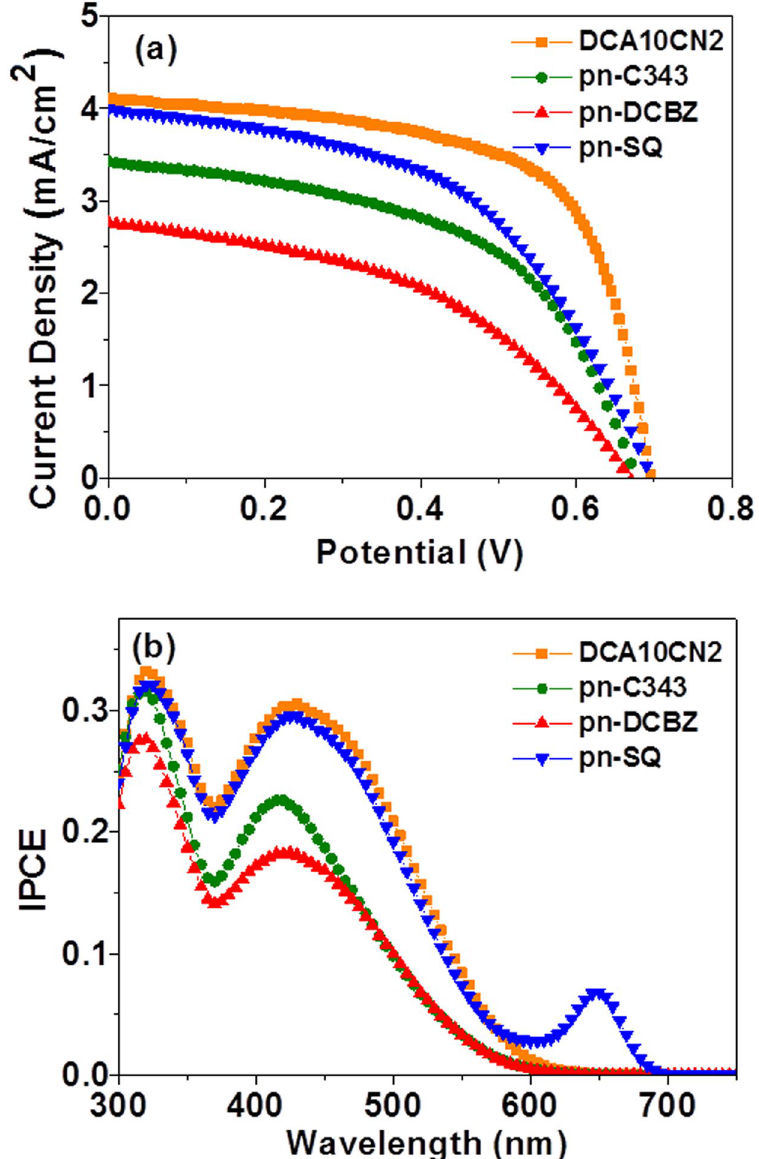
Figure 4. Photovoltaic characterization of pn-DSSCs illuminated through the n-side under AM 1.5 conditions (100 mW cm − 2 ). ( a ) Current density-voltage (J-V) characteristics and ( b ) incident photon-to-current conversion efficiency spectra